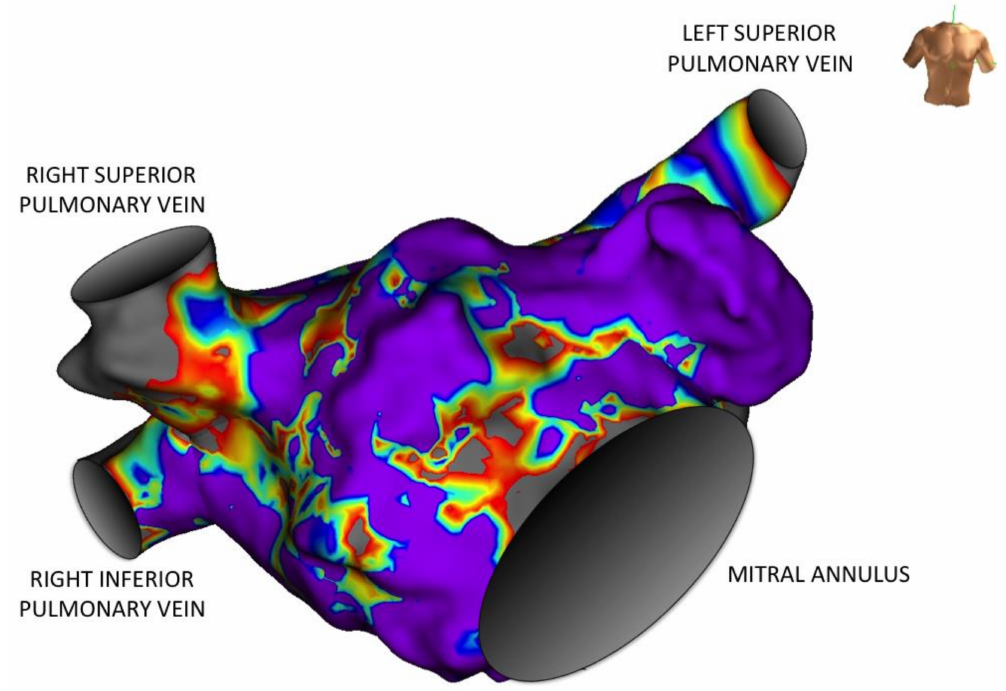
Figure 1. Three-dimensional voltage map of the left atrium obtained during invasive electrophysiological mapping (anterior view). The amplitude of local electrical activity is color-coded: from grey for low voltage areas to mauve for high voltage areas. Local amplitude correlates to the underlying atrial myocardial thickness, so that fibrotic areas translate into low voltage heterogeneous (“patchy”) anisotropic areas, here localized on the inter-atrial septum and the anterior